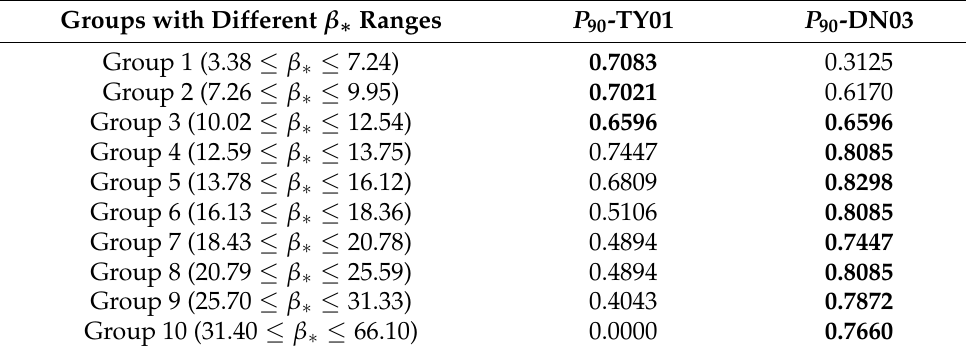
Table 6. P 90 of 10 groups divided according to β ∗ from low to high. Groups with Different β ∗